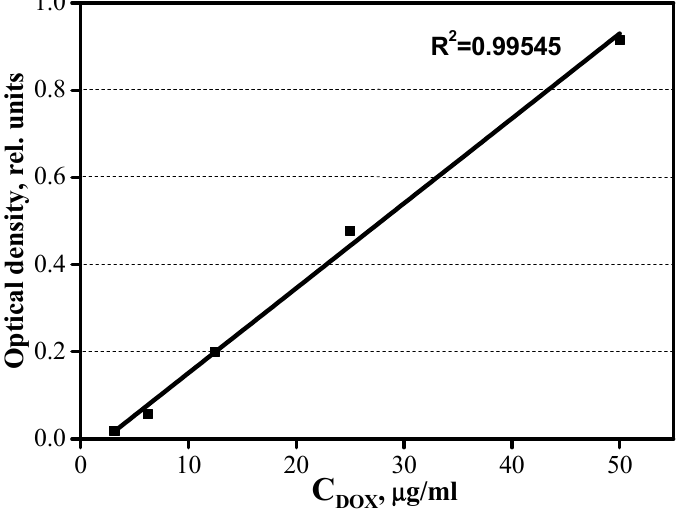
Figure 1. Calibration graph of the dependence of doxorubicin DOX concentration on the optical